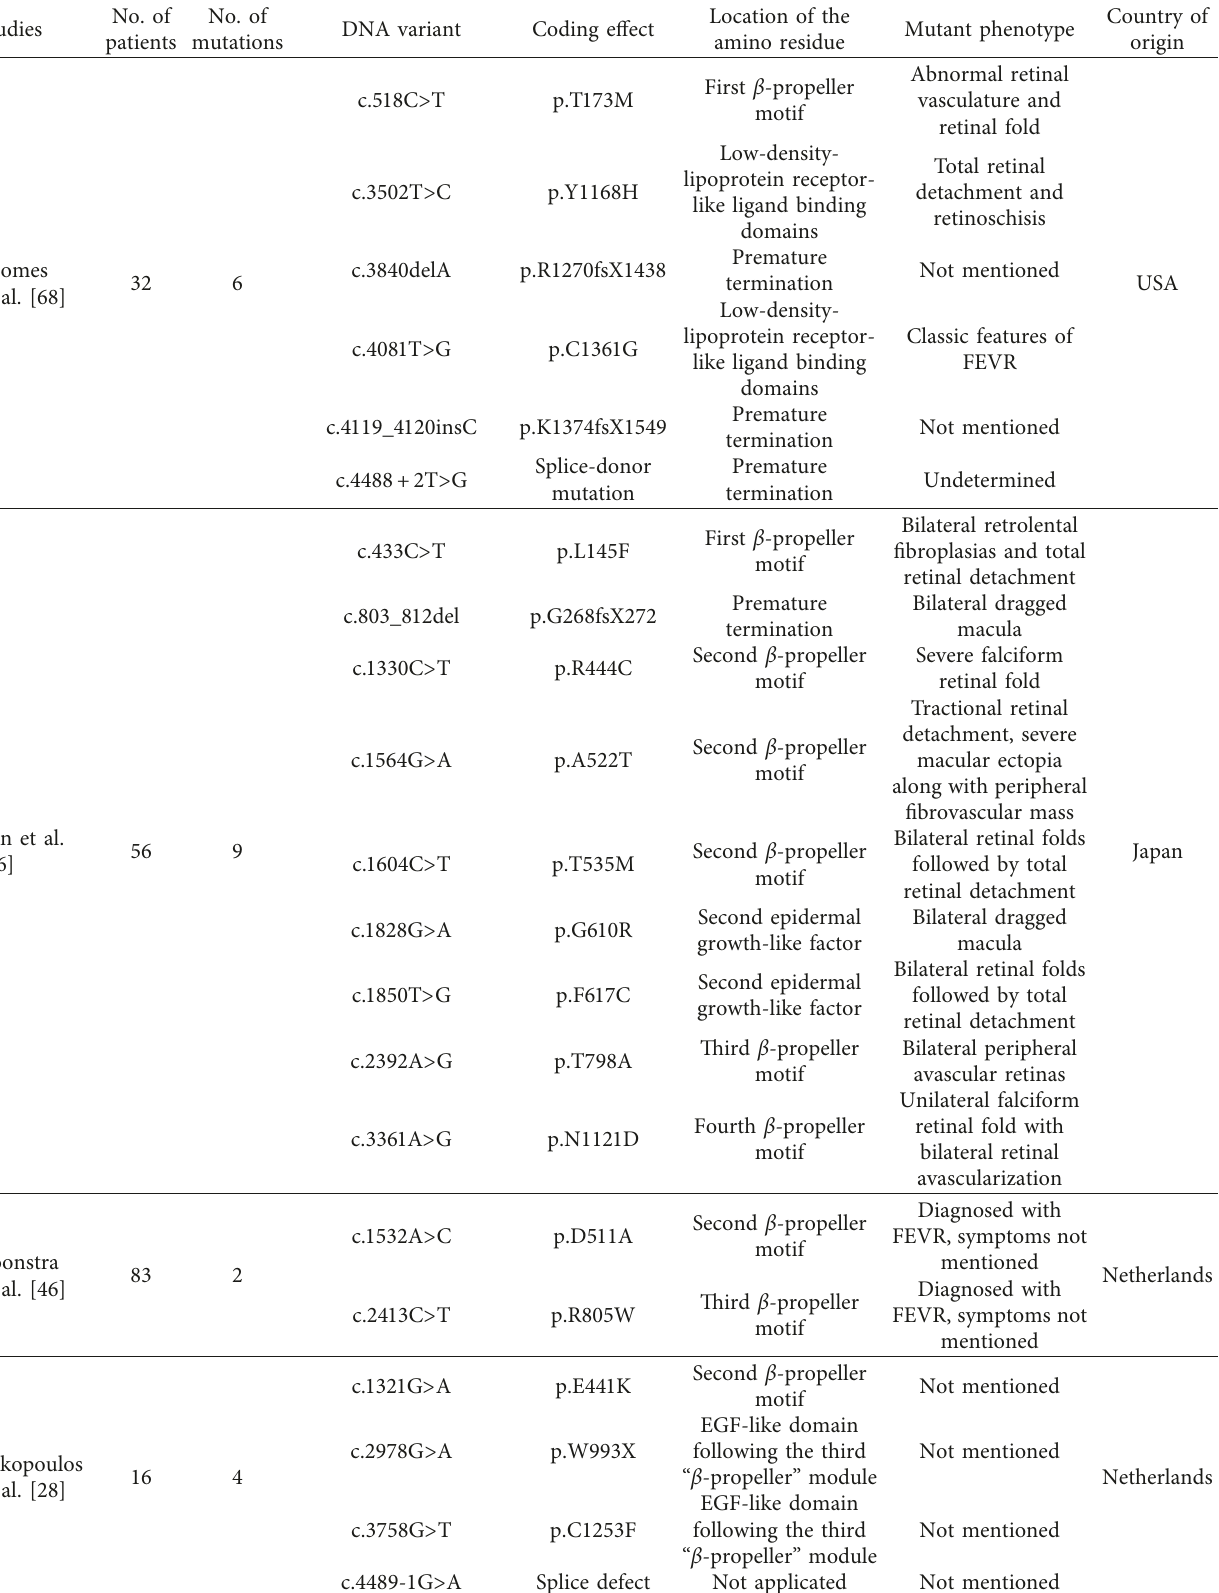
Table 3: Spectrum of LRP5 gene mutations among patients with familial exudative vitreoretinopathy. No. Studies